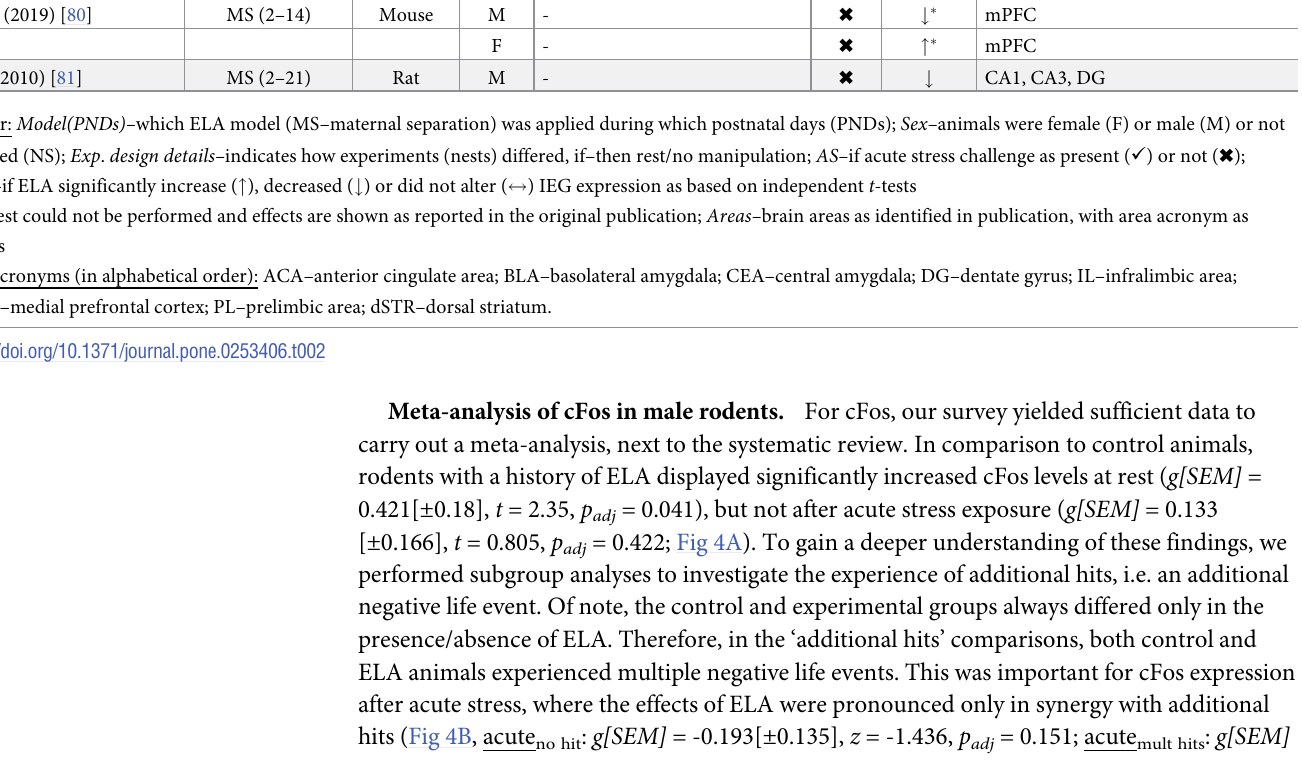
Table 3. Overview of study designs and findings of reviewed publications reporting on expression of the Egr-family in ELA and control